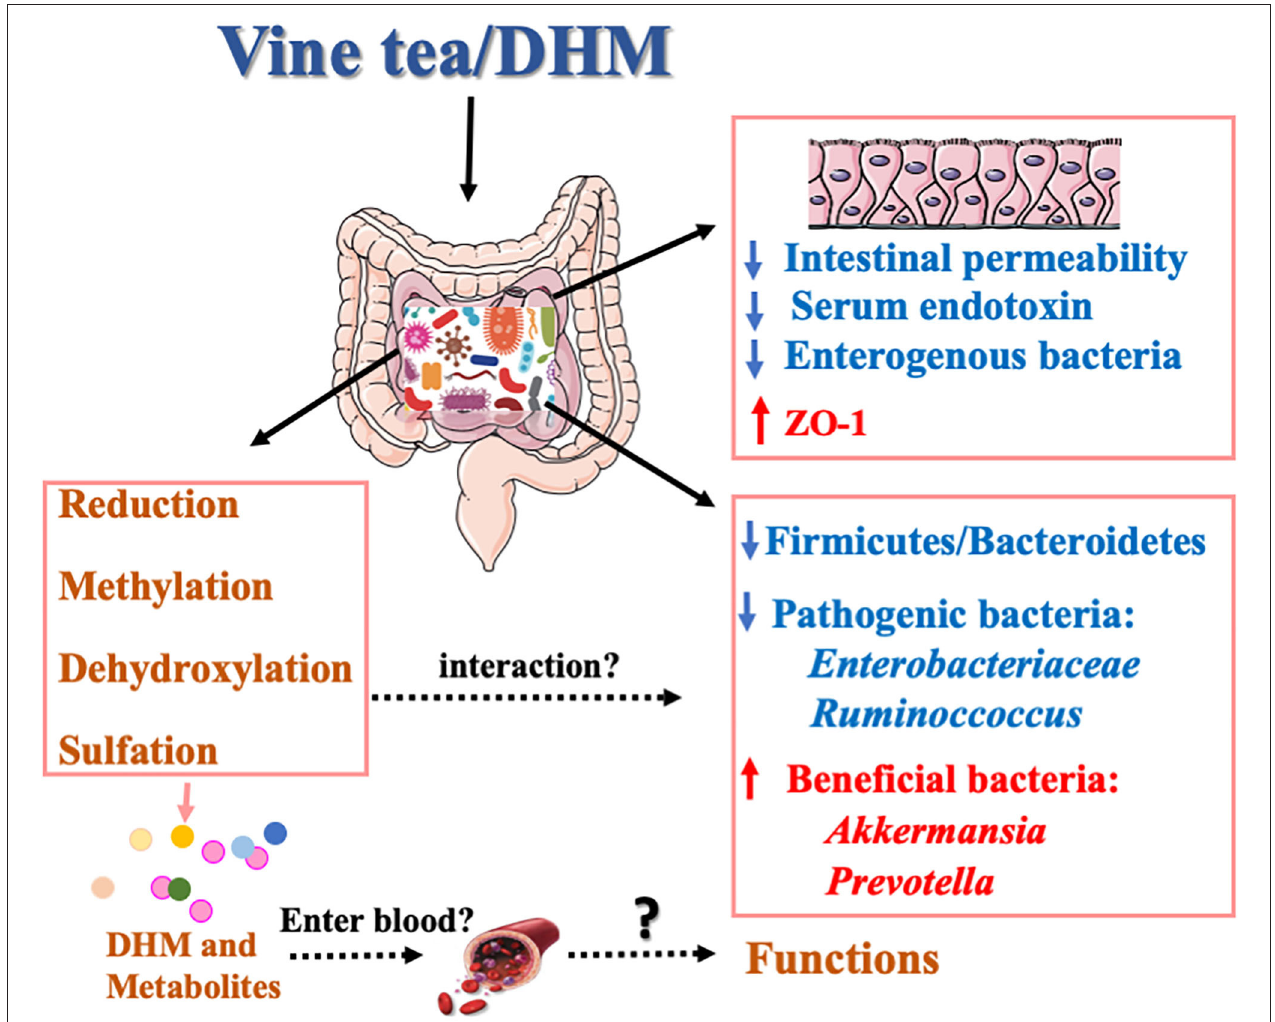
FIGURE 2 | Potential mechanism of interaction between DHM and gut